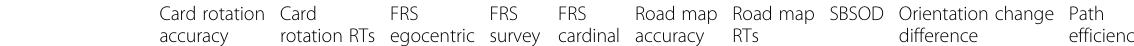
Table 2 Experiment 2 correlation matrix relating individual differences measures and behavior outcomes Card rotation